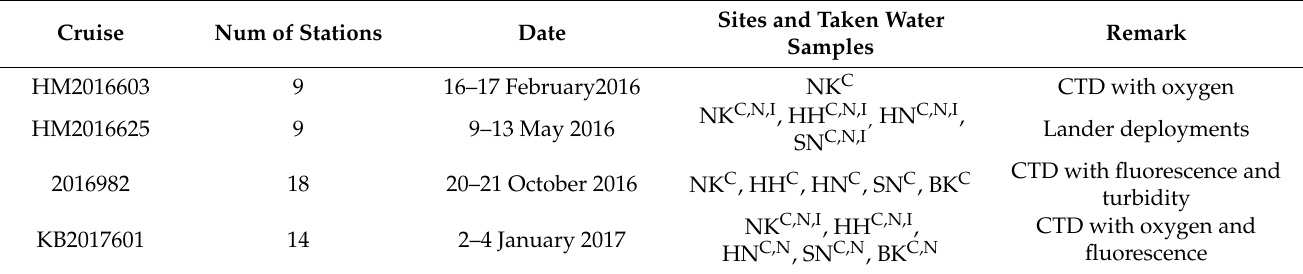
Figure 1. The map of ( A ) Langenuen on coastal Norway (white polygon) and Utsira coastal station (red dot), ( B ) CWC sites in Langenuen Fjord: bank reef Bekkjarvik (BV), live corals at depths 200–210, wall reef Straumsneset (SN), live corals at depths 80–220 m, wall reef Hornaneset (HN), live corals at depths 220–240 m, bank reef Nakken (NK), live corals at depths 190–220 m (white polygon) and wall reef Huglhammaren (HH), live corals at depths 80–220 m and ( C ) the Nakken reef area with lander deployment locations ~125 m apart from each other shown with stars. MLM = lander deployed on the CWC bank, SLM = lander deployed south of the CWC bank. Table 1. Summary of cruises, visited locations, and measurements between February 2016 and August 2017. Abbreviations; HM = Håkon Mosby, KB = Kristine Bonnevie, NK = Nakken, HH = Huglhammaren, HN = Hornaneset, SN = Straumsneset, BK = Bekkjarvik. C = carbonate chemistry (A T and C T ) samples, N = nutrient samples, I = isotope